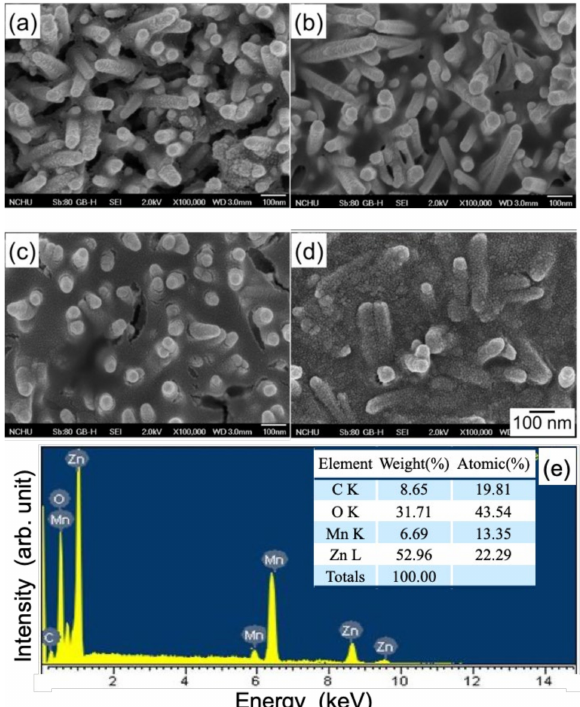
Figure 5. SEM micrographs of the MnOx-coated ZnO nanorod for MnOx deposition times of ( a ) 10, ( b ) 20, ( c ) 30, and ( d ) 40 s. ( e ) shows the EDX spectrum and elemental composition of the MnOx-coated ZnO nanorod at a deposition time of 10 s. The MnOx was coated by anodic deposition in a 0.25 M Mn(CH 3 COO) 2 · 4H 2 O solution at 25 ◦